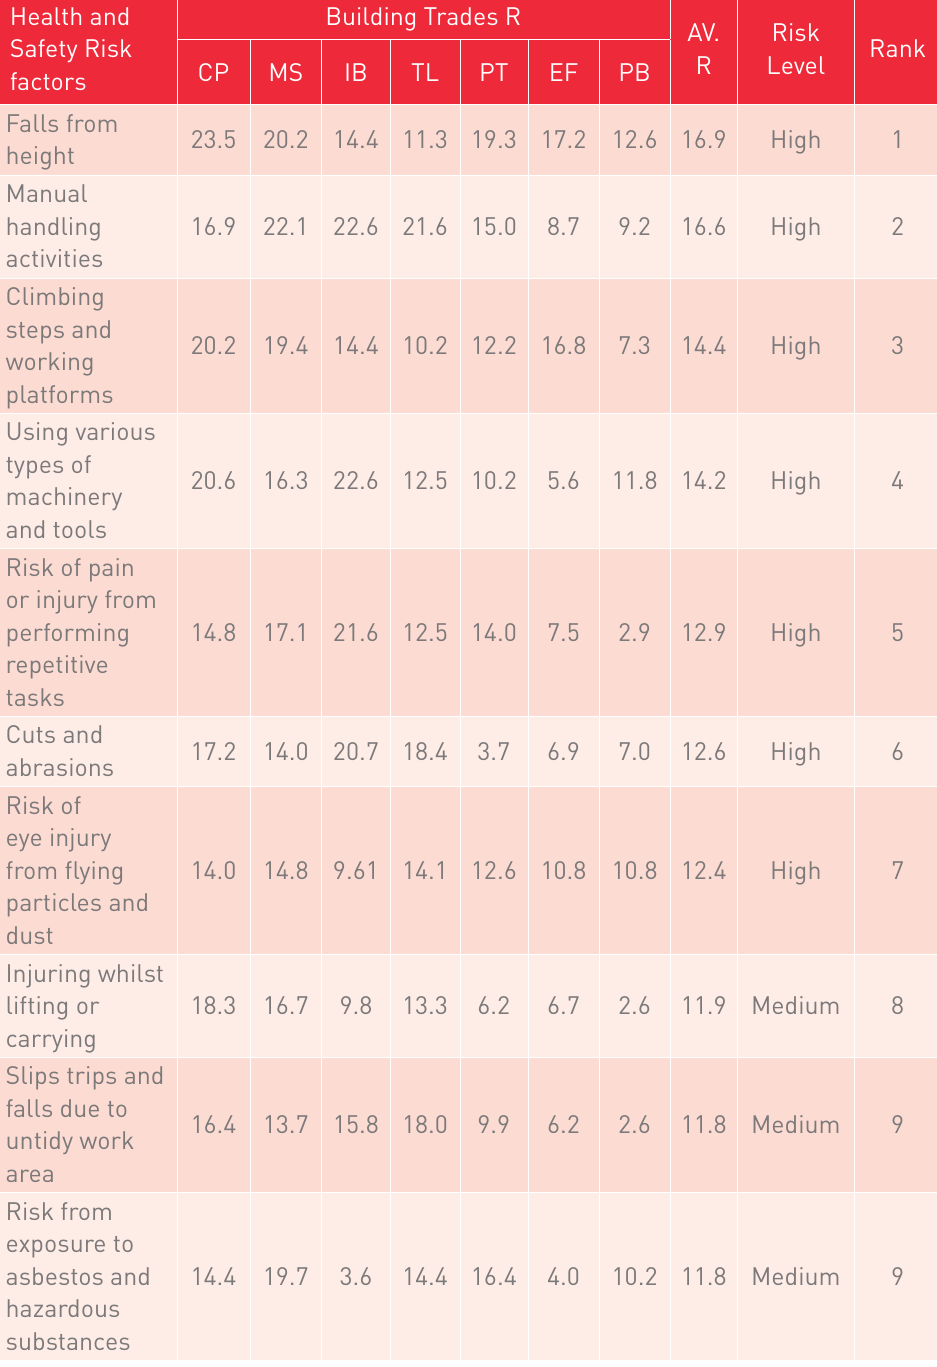
Analysis of risk level of health and safety risk factors in building